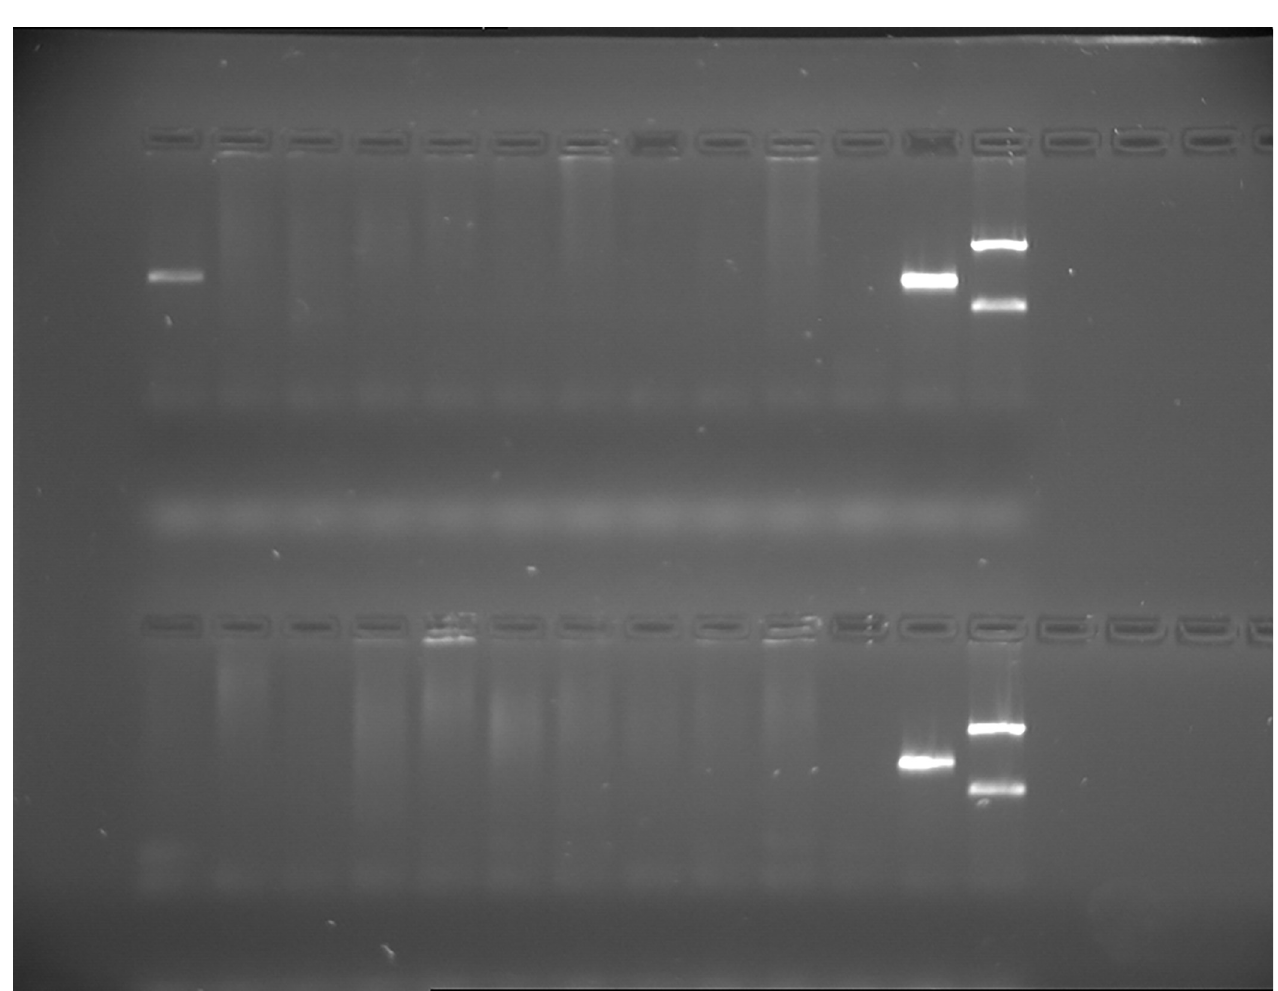
Fig 8. The distribution of a PCR product for P . gingivalis for atherosclerotic plaques.